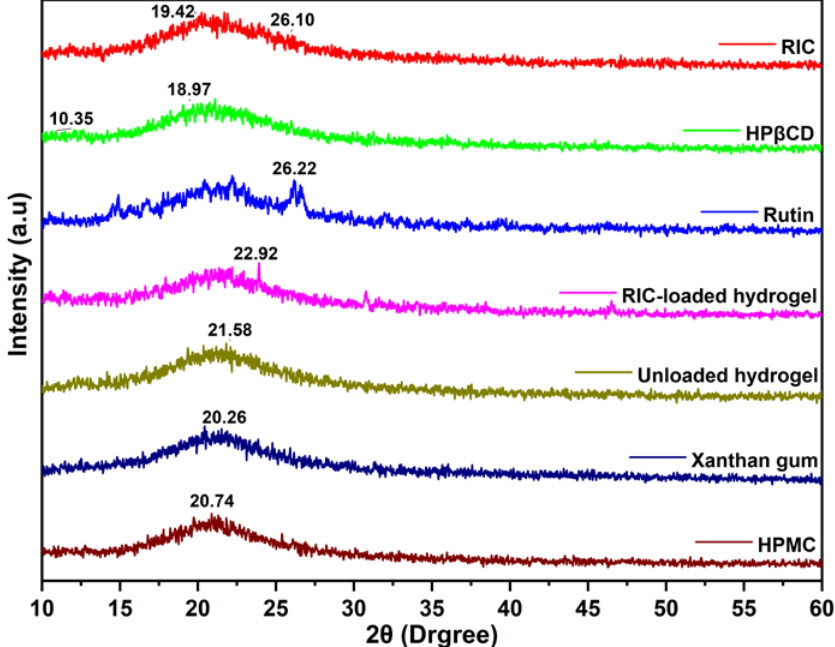
Figure 5. XRD pattern of formulation components, inclusion complexes, and synthesized hydrogels.